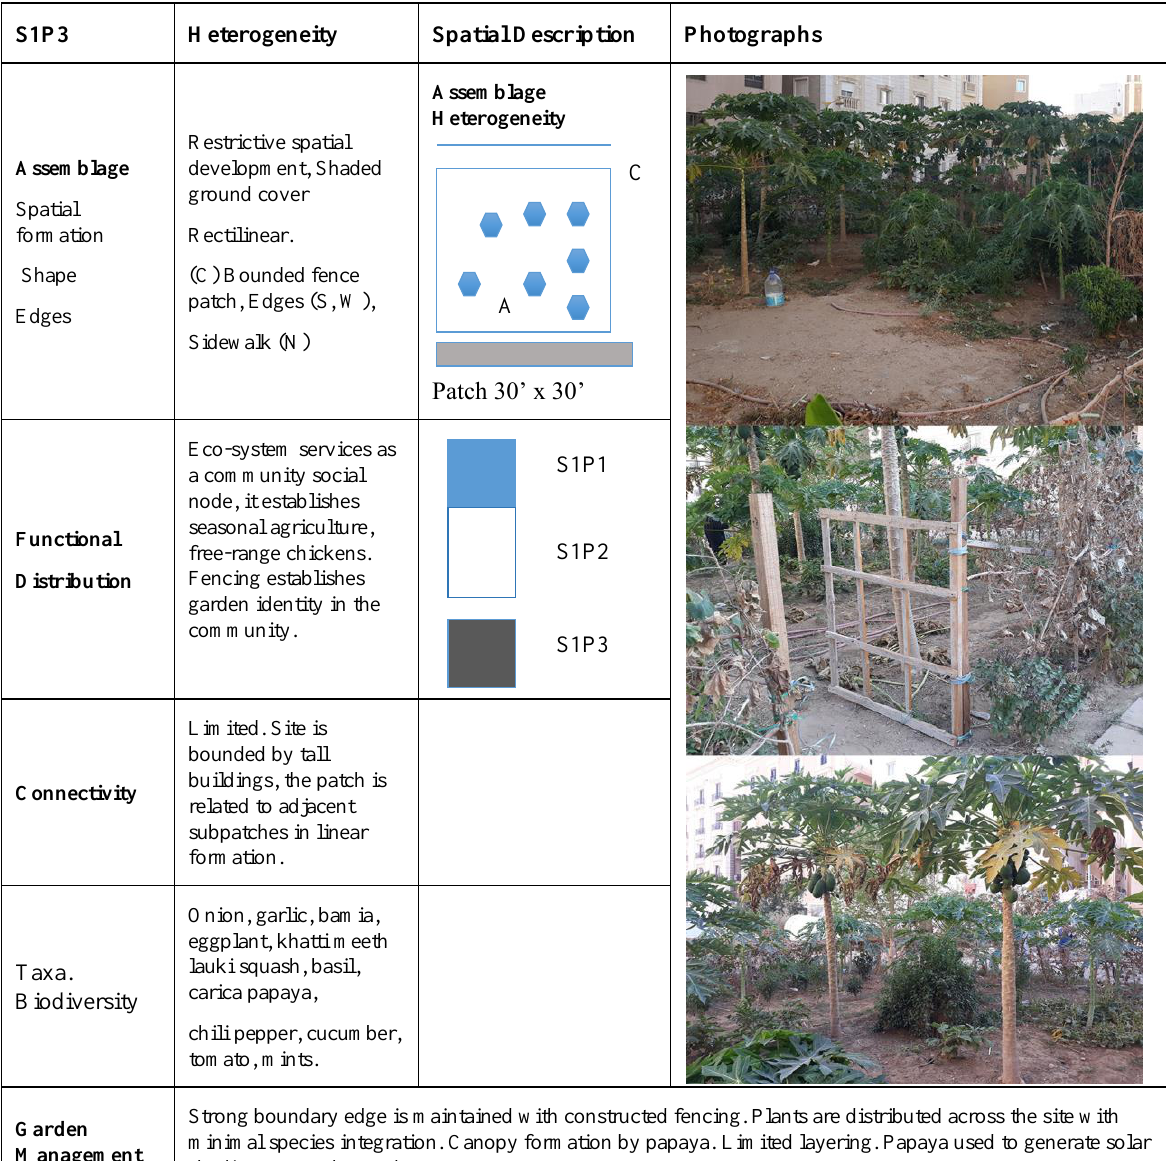
Table 4. S1 P3 description of constructed